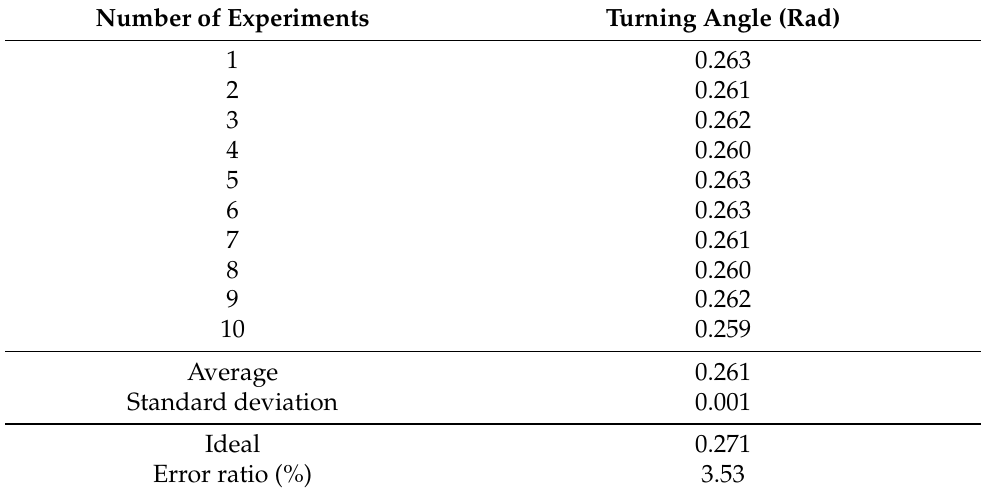
Table 7. The results of the counter-clockwise turning locomotion